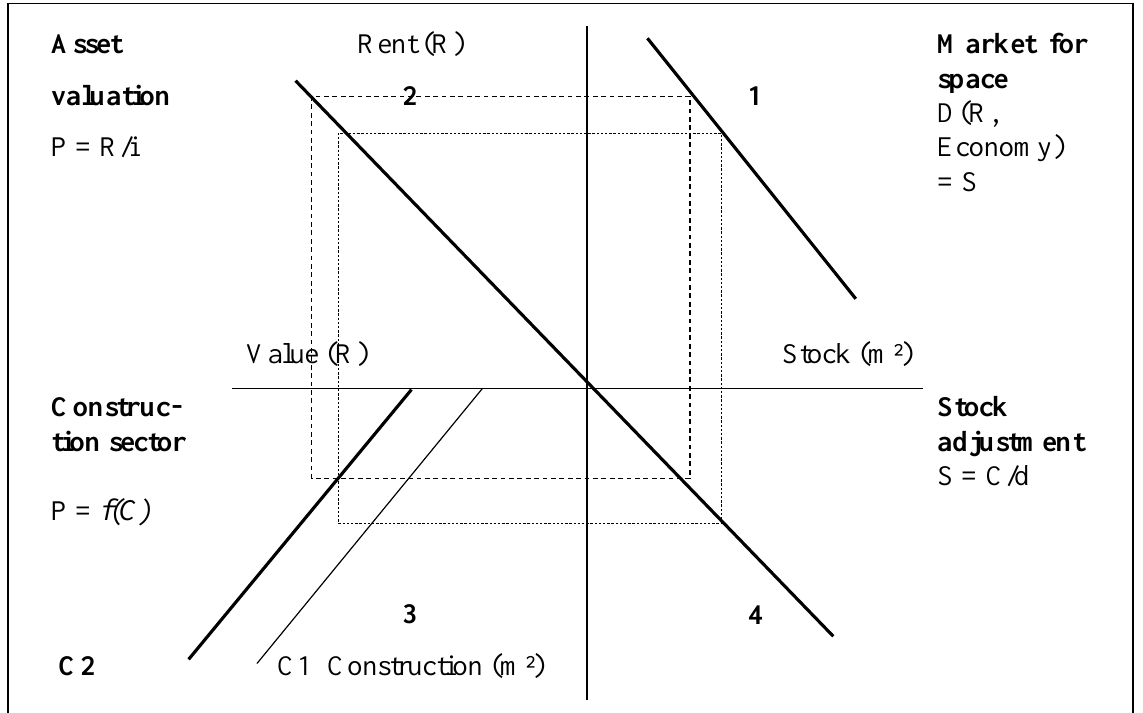
Shift in construction costs in terms of the Pretoria